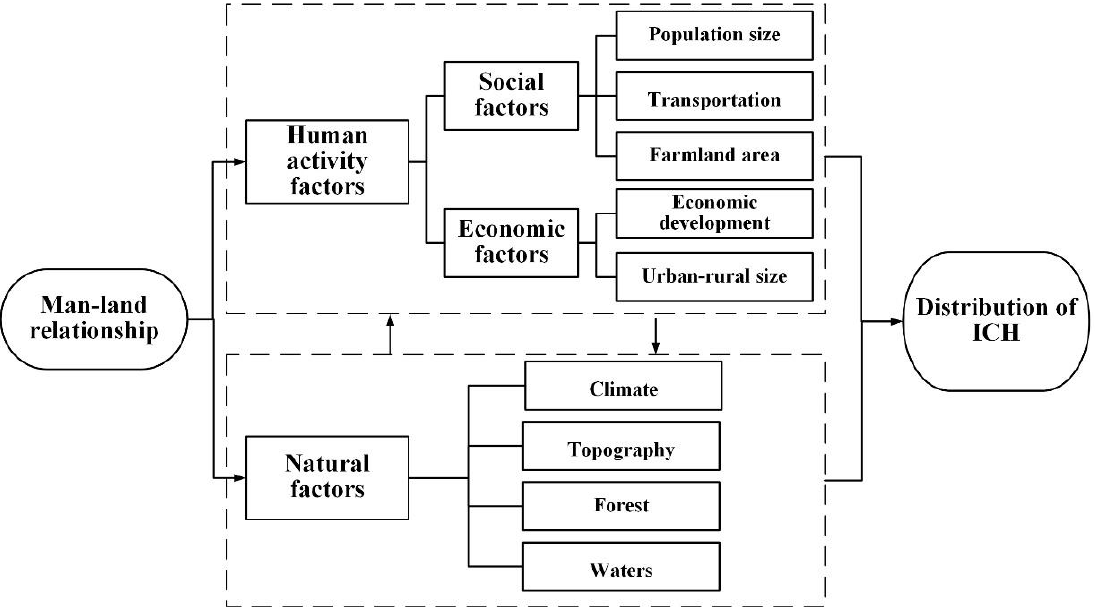
Figure 2. Theoretical framework.